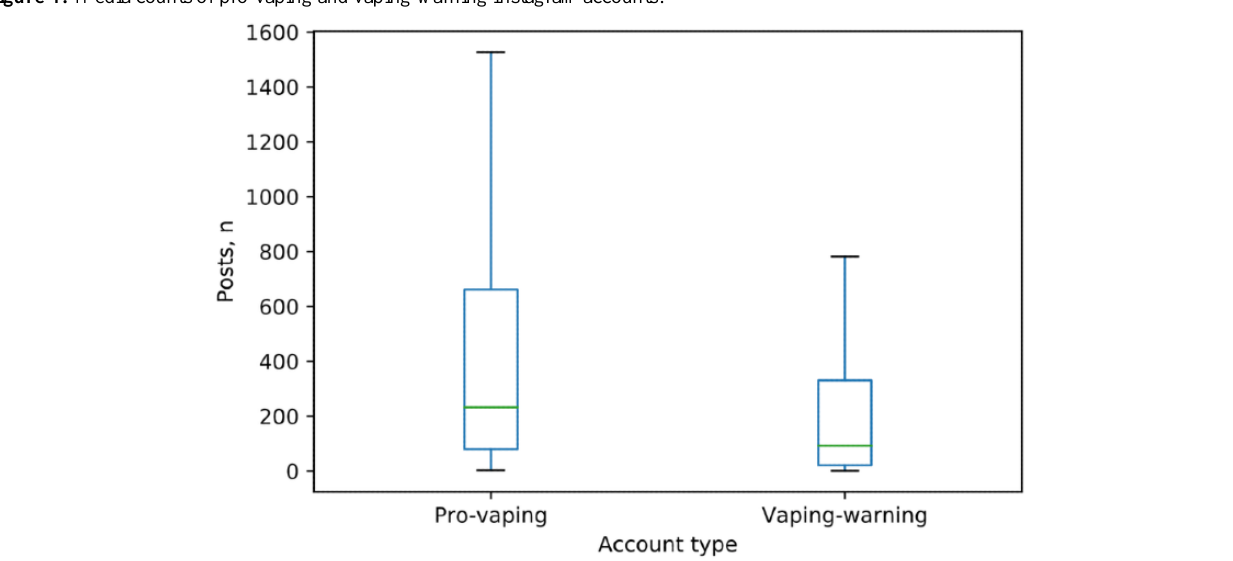
Figure 4. Media counts of pro-vaping and vaping-warning Instagram